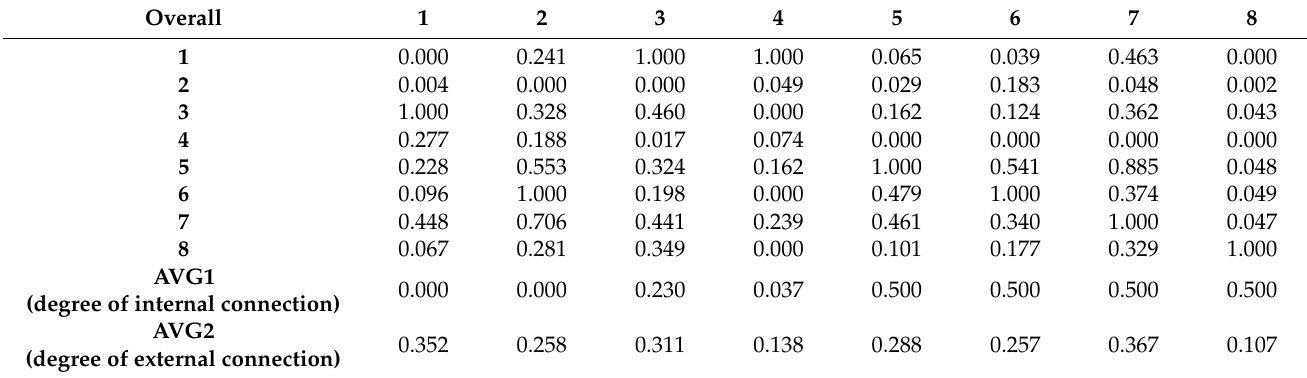
Table 3. Density matrix of the cohesive subgroups in the tourism flow